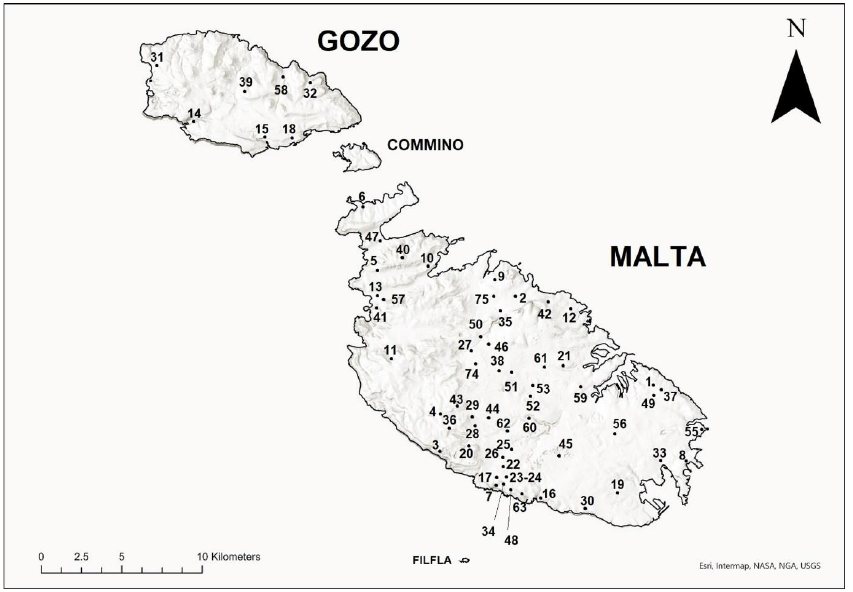
Figure 1. Map of the Maltese Islands (Gozo and Malta) showing the locations where data were collected between 2015–2022 (with names, habitat description and predominant vegetation of locations indicated in Table 1). Table 1. Locations where data were collected for this study: habitat type and brief description. Site No.